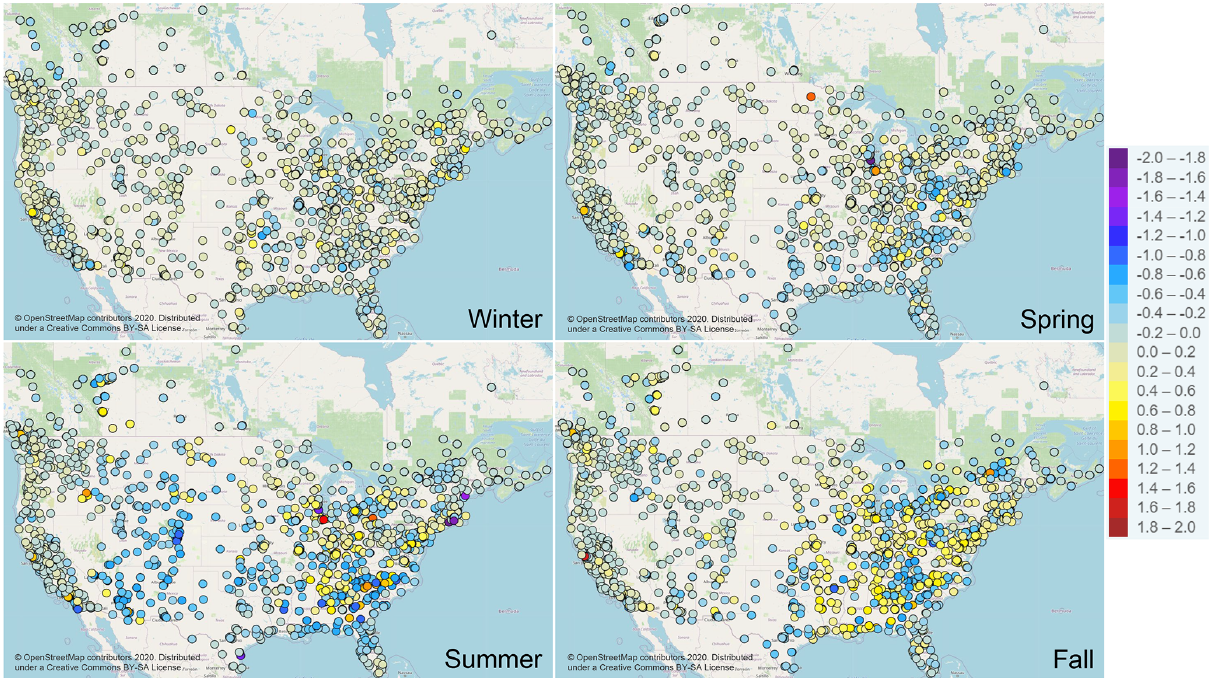
Figure 13. Seasonal average PM 2 . 5 absolute bias difference (µgm − 3 ) between the CMAQ531_WRF38_M3Dry_BiDi and CMAQ531_WRF411_M3Dry_BiDi simulations for all AQS and NAPS sites to highlight the impact of the updated WRF version. Cool shading (negative values) indicates smaller bias in the CMAQ531_WRF411_M3Dry_BiDi simulation, and warm colors (positive values) indicate smaller bias in the CMAQ531_WRF38_M3Dry_BiDi